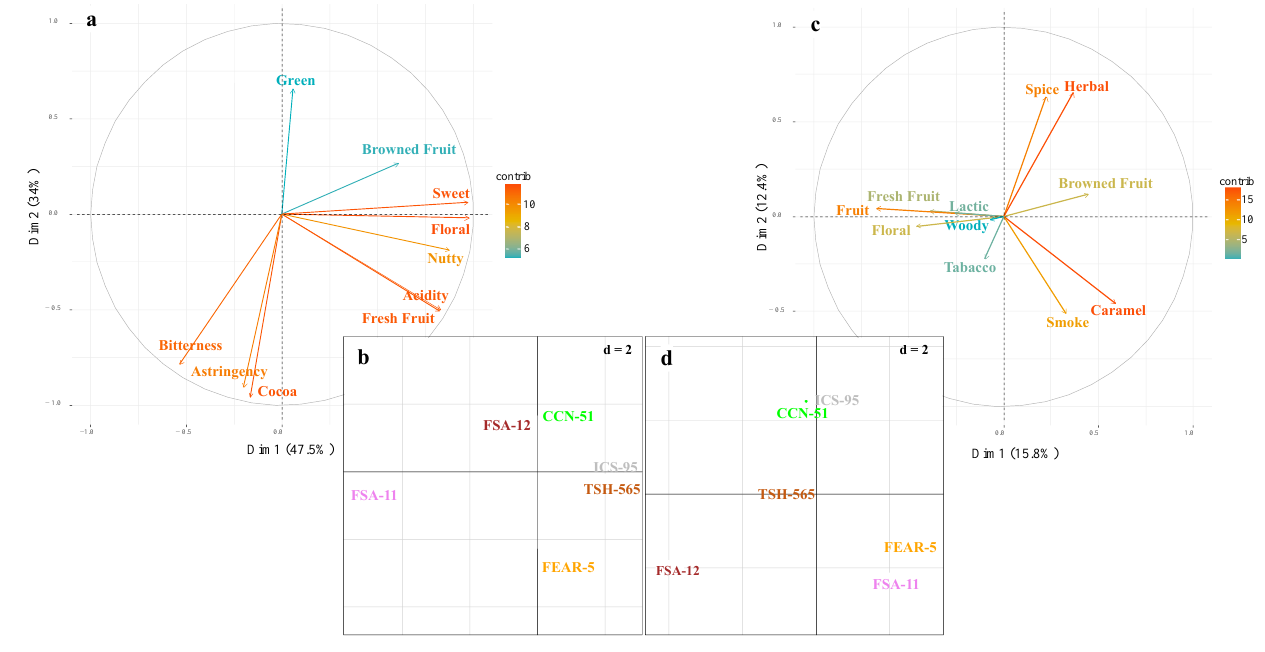
Figure 3. Principal component analysis of the matrix of sensory profile and cocoa notes according to cocoa clones from the department of Meta, Colombia. ( a ) organoleptic qualities, ( b ) distribution of cocoa clones in relation to organoleptic qualities, ( c ) sensory notes, ( d ) distribution of cocoa clones in relation to sensory notes. The color of each variable shows the level of contribution in each component, where green and red is higher to lower contribution.